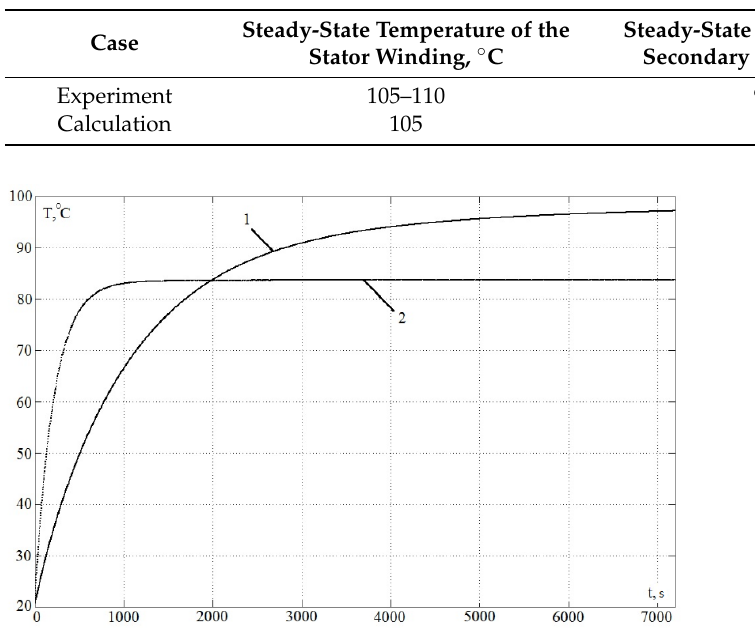
Figure 15. Average temperatures of the arc LIM during soft start. 1—stator winding; 2—secondary surface layer.